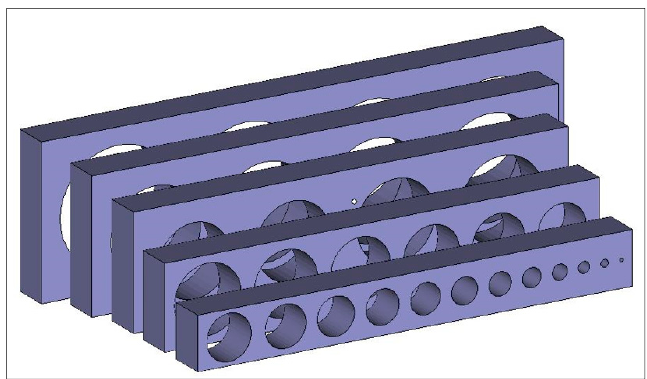
Figure 1. Design of the round overhang holes.